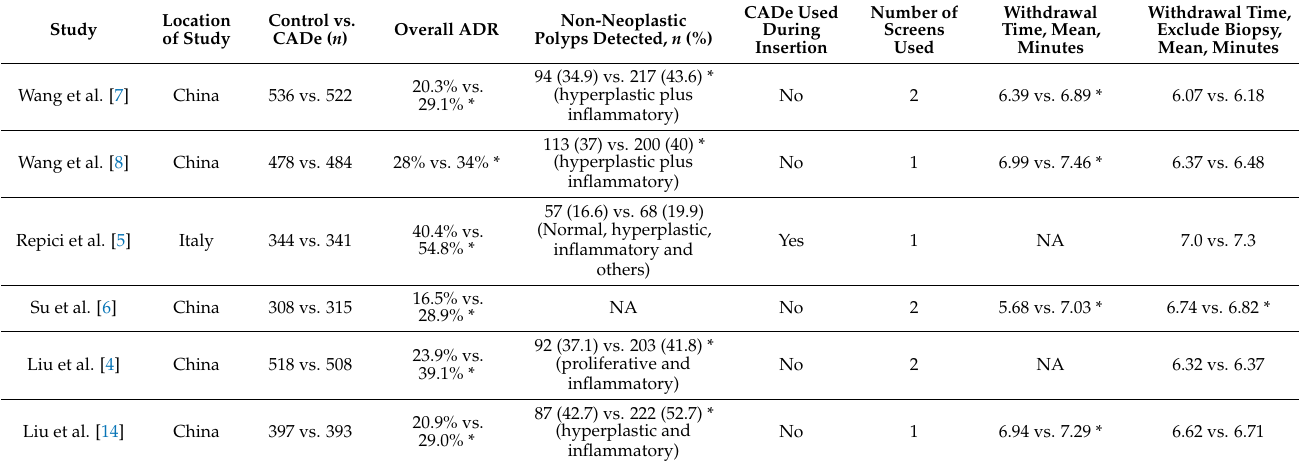
Table 3. Recent RCTs comparing real-time CADe with control on adenoma detection during